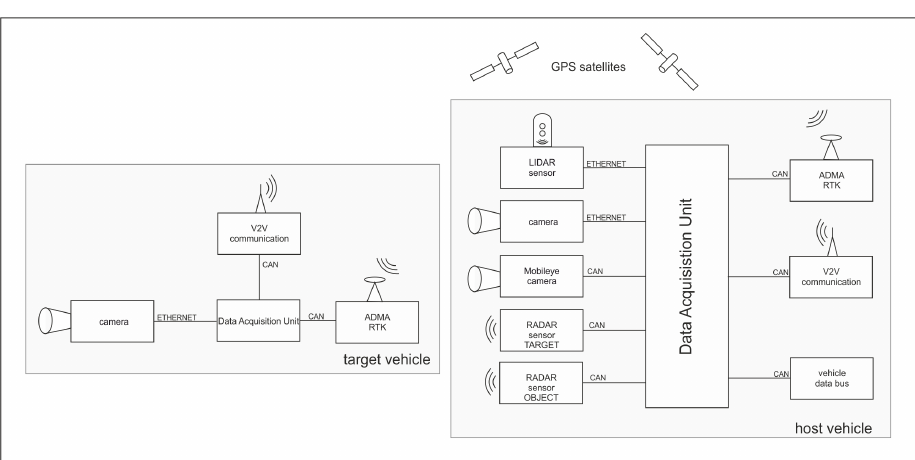
Figure 18. TU Graz vehicles: BMW 640i and Seat Leon.